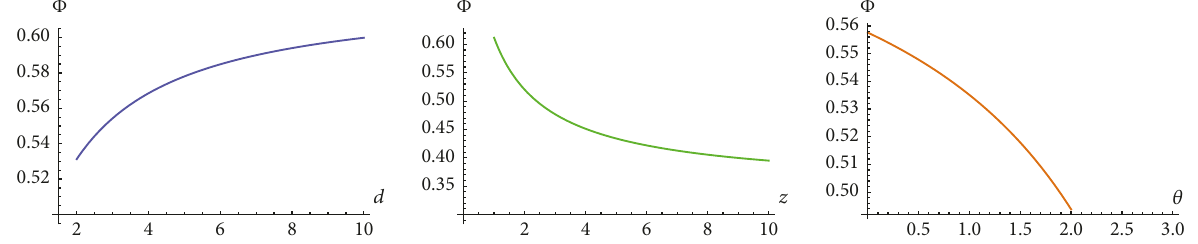
Figure 15: Relative phase Φ of entanglement entropy as a function of (a) dimension, (b) 𝑧 , and (c) 𝜃 . In (a), we have {𝑧 = 1.5,𝜃 = 0.1} . In (b), we have {𝑑 = 3,𝜃 = 0.1} and in (c), {𝑑 = 3, 𝑧 = 1.5} . We have set Ω = 1